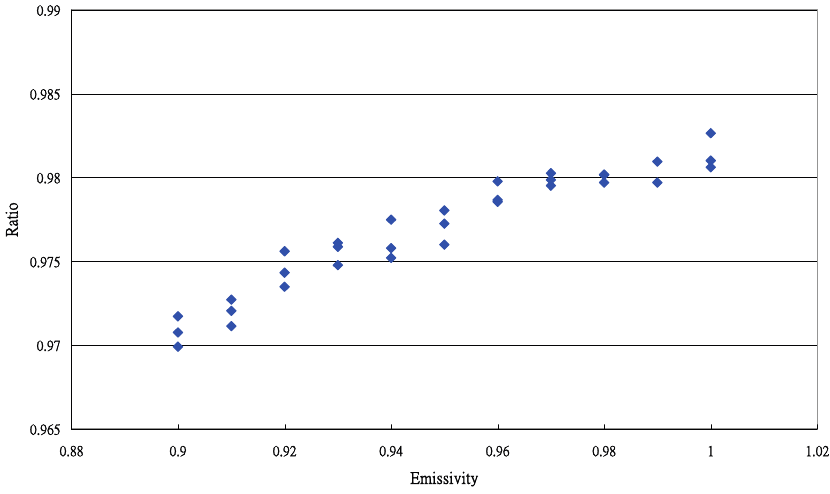
ε value for ε ) and is T